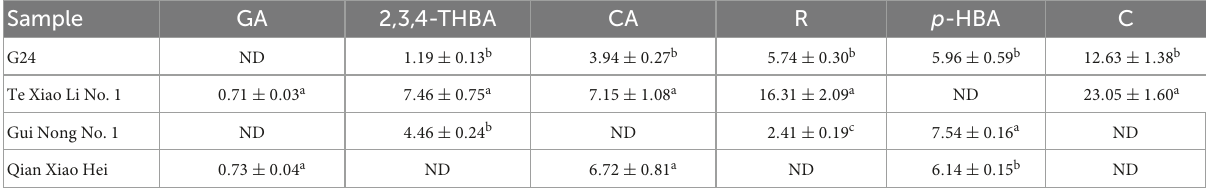
TABLE 2 Phenolic compound profiles (mg/100 g DW) of adzuki beans.